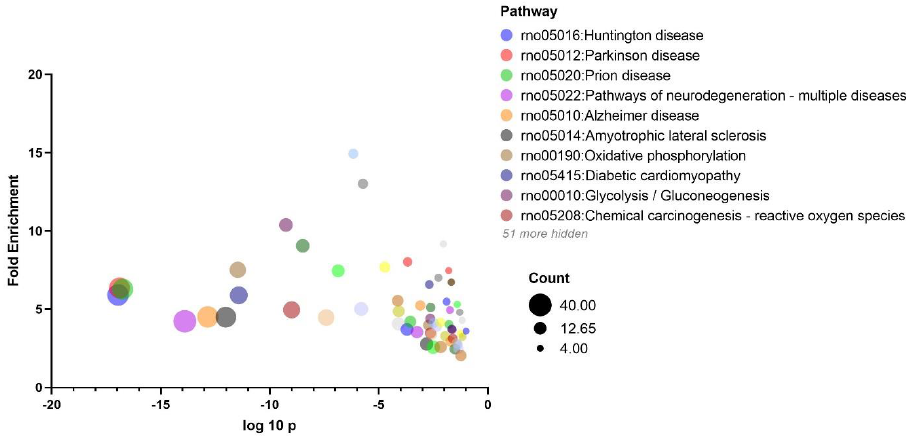
Figure 4. Bubble chart shows KEGG analysis of differential genes. The vertical axis represents the rich factor (ratio of the sum of differential genes enriched in a pathway to the number of genes annotated by the pathway). Bubble size indicates the number of proteins included in each pathway, and different colors indicate different pathways. As shown in Figure 5, the most protein – protein interactions were observed between proteins associated with carbon metabolism, Parkinson’s disease, and diabetic cardiomy- opathy pathways.